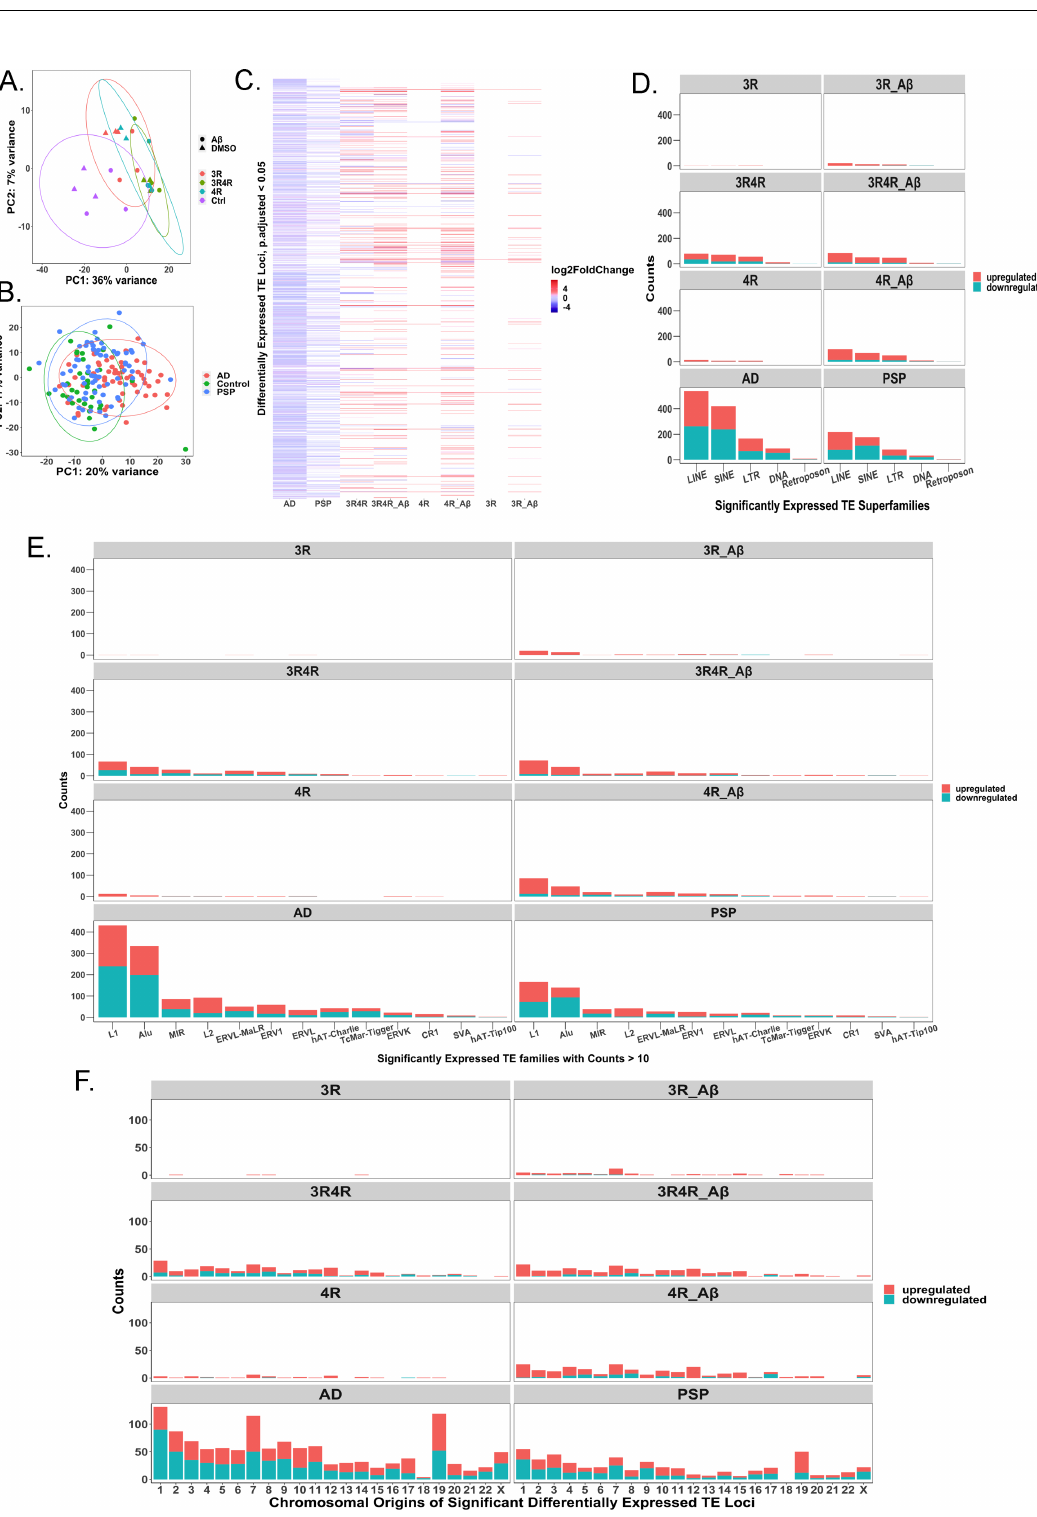
PLOS ONE | https://doi.org/10.1371/journal.pone.0251611 September 29,